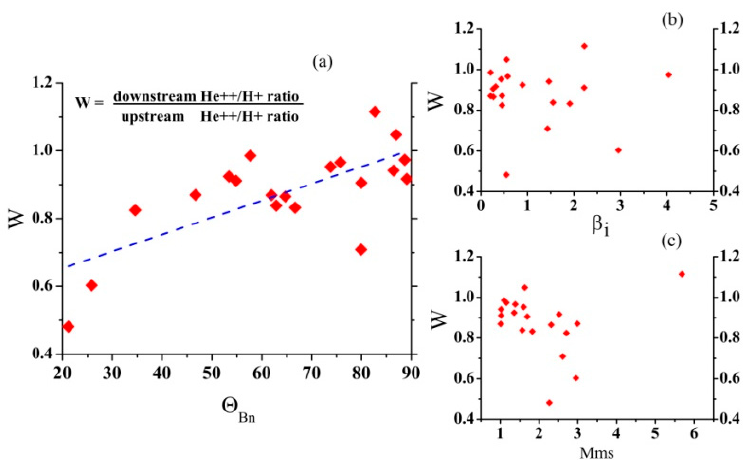
Figure 7. Dependence of the change in helium abundance N α /Np during the passage of the IP shock front on the parameters ( a ) θ Bn , ( b ) β i , and ( c ) M MS .